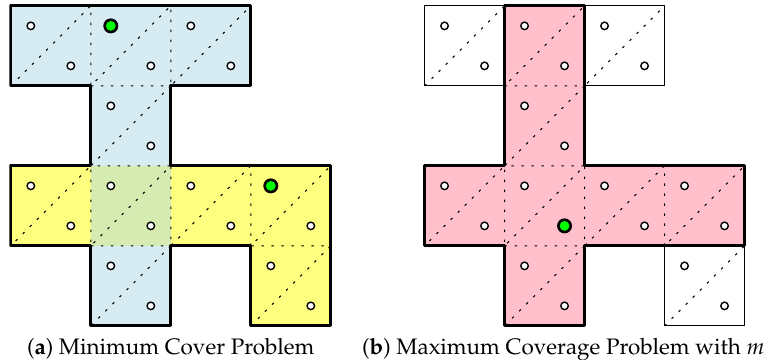
Figure 4. Example of the minimum cover problem and the maximum coverage problem with the visibility constraint. Green dots indicate selected seed